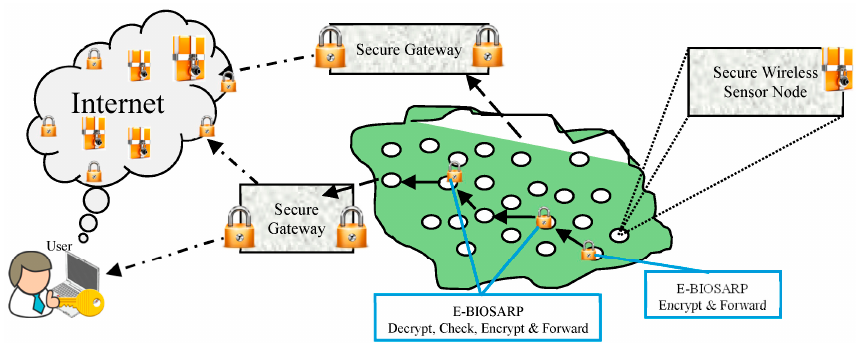
Figure 1. Illustration of a secure WSNs.